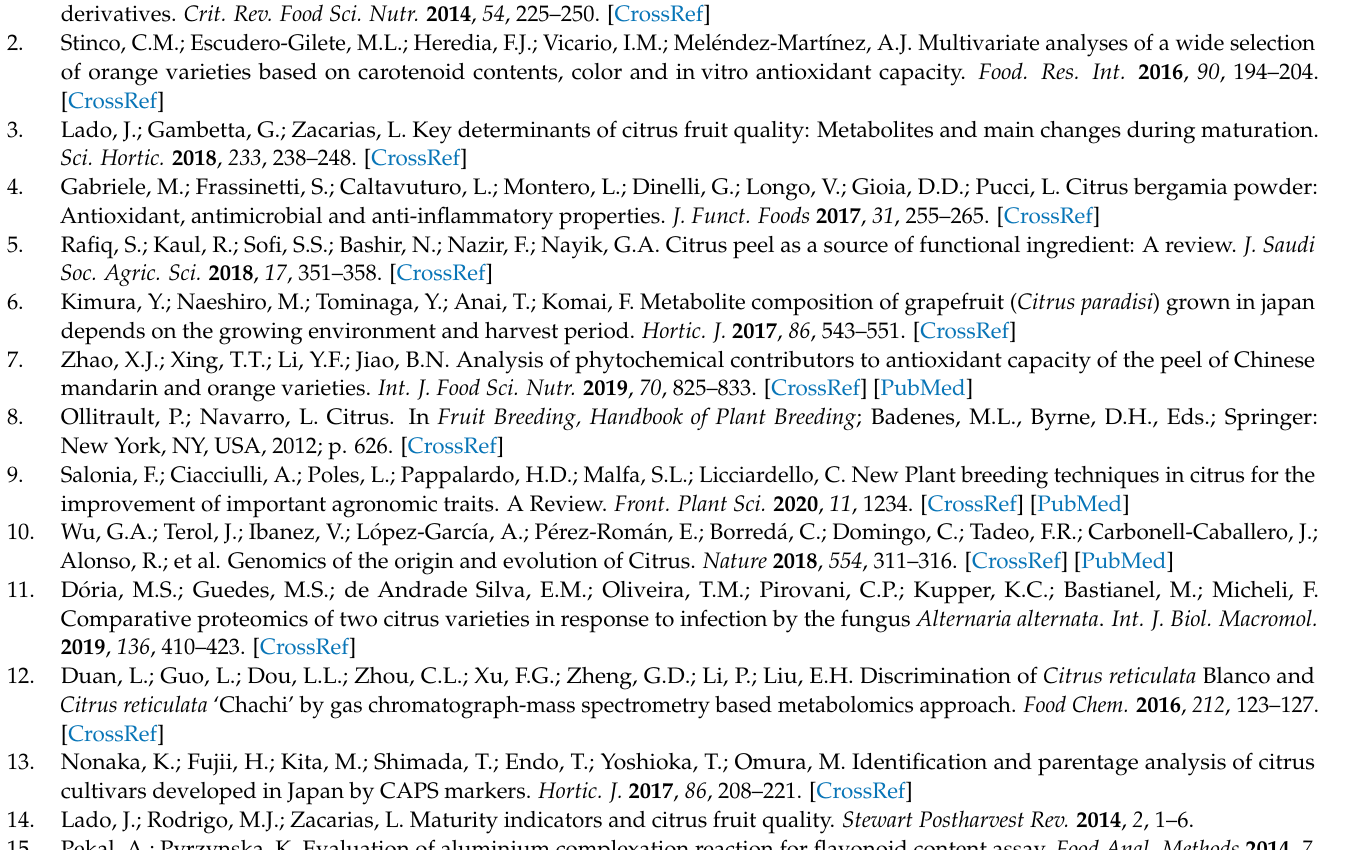
parameters., Table S1: Result of goodness of fit for each PLS-DA model, Table S2: Identification of major metabolites analyzed by GC-MS, Table S3: Identification of major metabolites analyzed by UPLC-Q-TOF MS, Table S4: Identification of major metabolites analyzed by HPLC, Table S5: Correlation between citrus quality characteristics and metabolites based on PLS-biplot, Table S6: Correlation between citrus varieties and citrus qualities, and metabolites based on